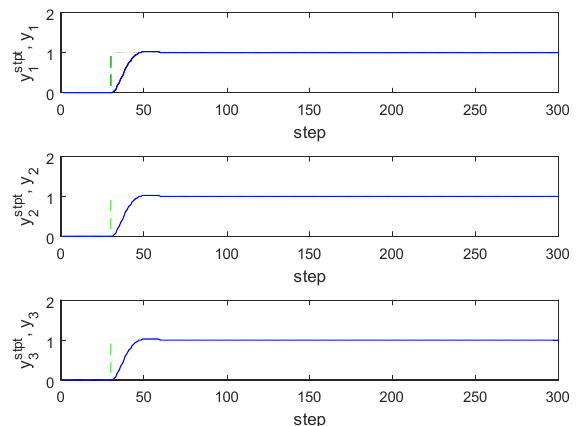
Figure 8. GPC with the 9th order internal model—closed loop simulation of 300 time-steps; dashed line is a set point, solid is a CV, and control parameters as: control horizon N u = 20, prediction horizon N = 400, and the R matrix = identity matrix